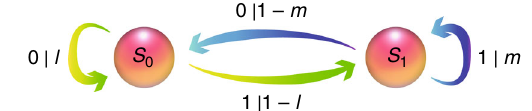
Fig. 1 Perturbed coin. The process that we study here is a coin with two outcomes, 0 and 1. The transition probabilities, T ij , between different outcomes are determined by l and m for i , j ∈ {0, 1}. The optimal classical model uses the causal states ({ S i }) depicted in the circles. There is a simple mapping from the past of the process to the relevant causal state: the last outcome from the coin determines the input causal state. Arrows, with the associated expressions j | T ij , represent the transitions from causal states S i to S j with probability T ij , emitting the classical outcome j . In the quantum model, the causal states become quantum states, {| S i 〉 }